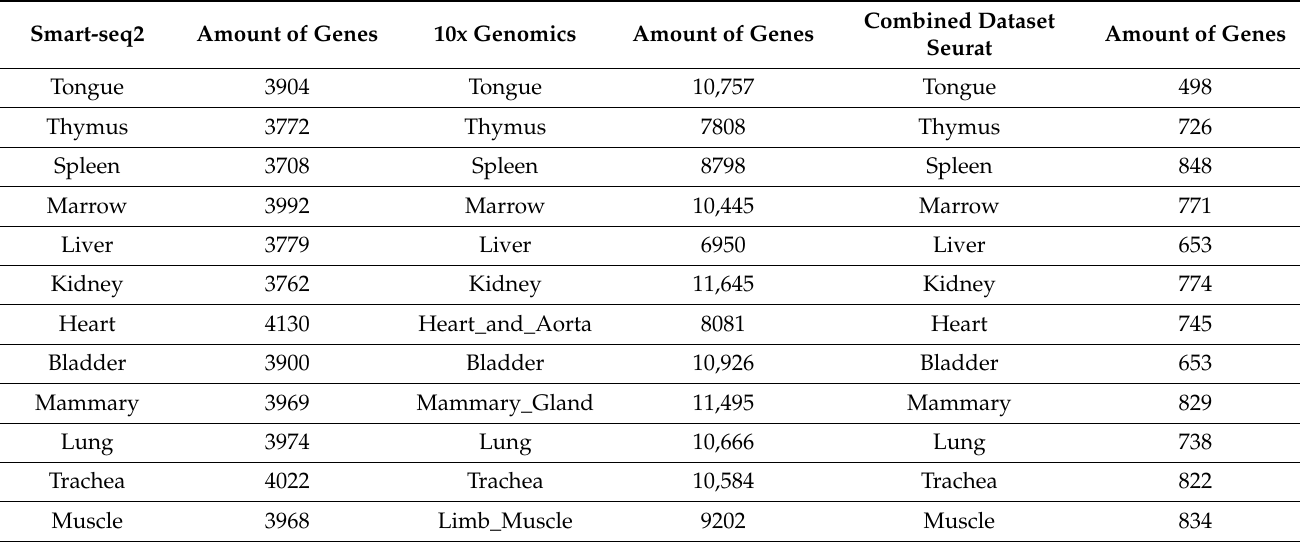
Table 1. Datasets from Tabular Muris included in the study and the number of genes in each dataset used for training (after extracting the Hallmark genes and filtering or batch